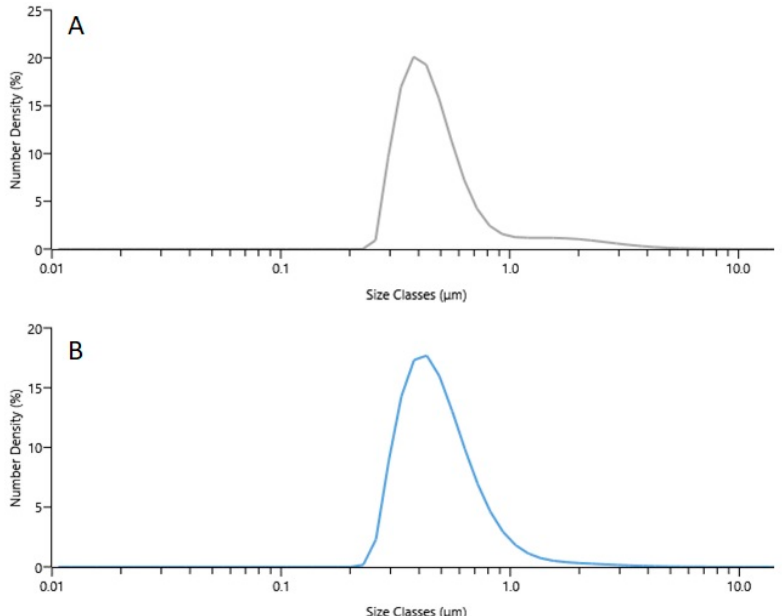
Figure 2. Essential oil particles’ distribution in microcapsules ( A )—LM microcapsules, ( B )—SDM microcapsules.